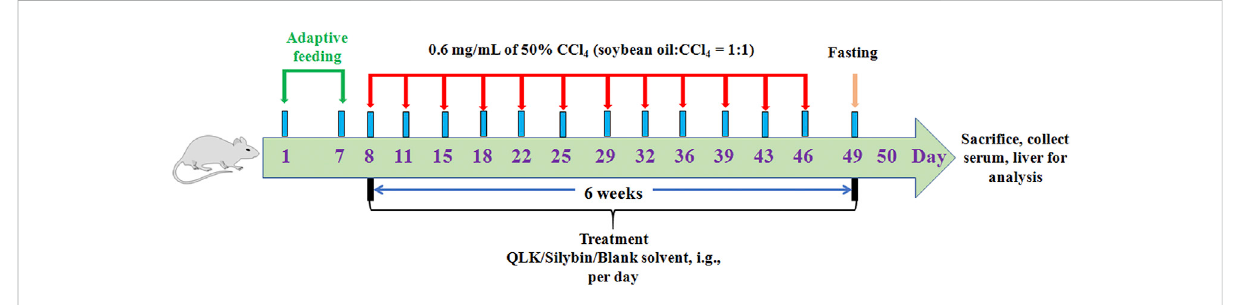
FIGURE 1 Diagrammatic sketch of the experimental design of the effect of QLK on rat liver fi